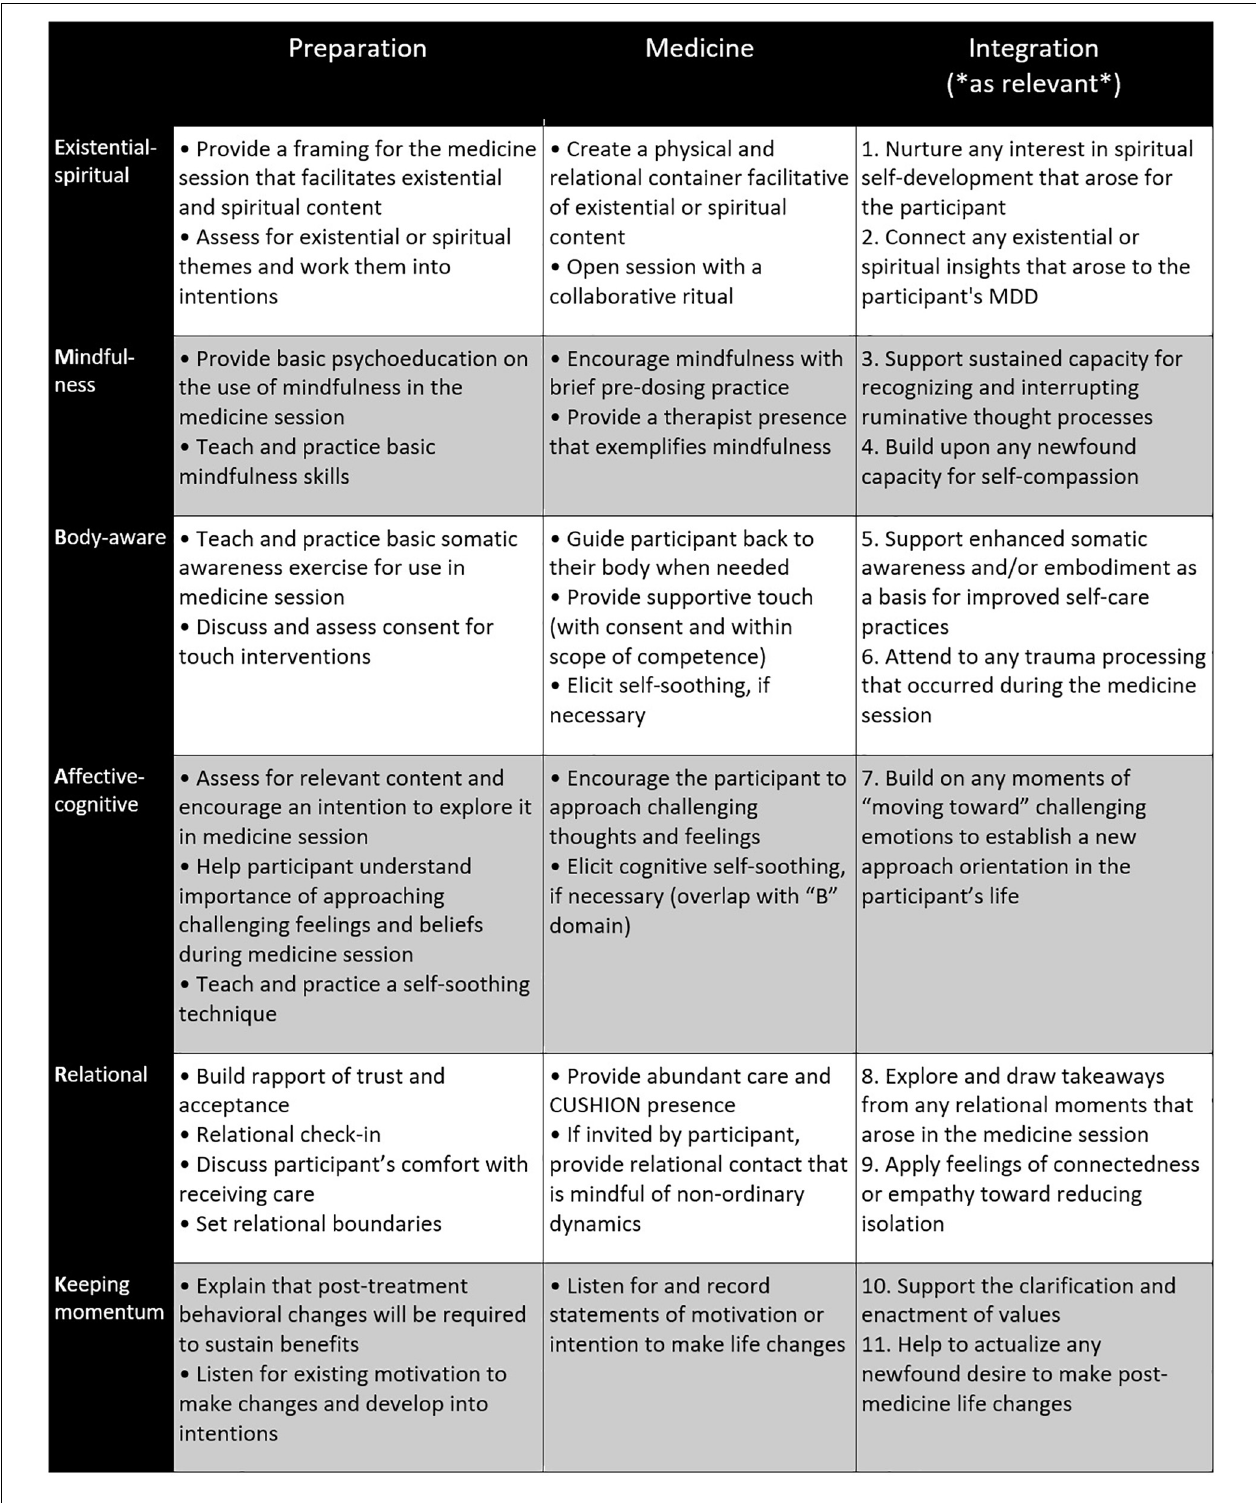
FIGURE 1 | Domain-specific therapist tasks across three treatment phases of EMBARK approach to MDD. Integration aims are numbered to correspond to the integration aim guidance checklist ( Figure 3 ).